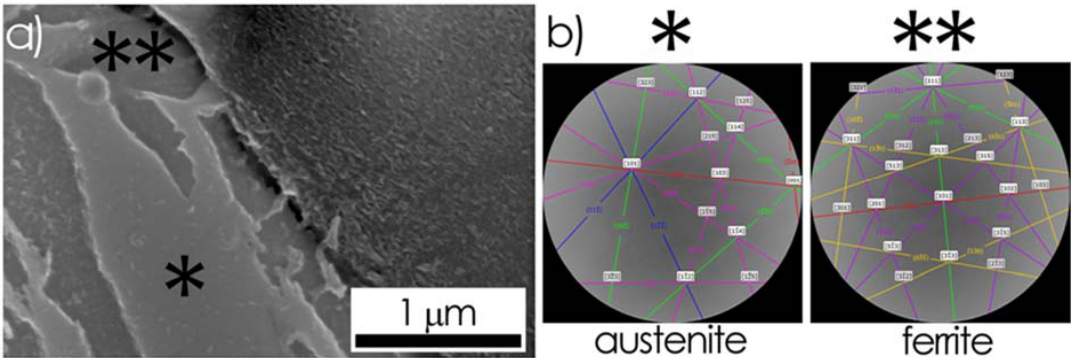
Figure 13. Local debonding path at the G ‐ M interface in the ADI390 specimen, at a distance of 3 mm from the fracture: ( a ) SEM image, ( b ) electron backscatter diffraction patterns acquired from microregions marked in ( a ).